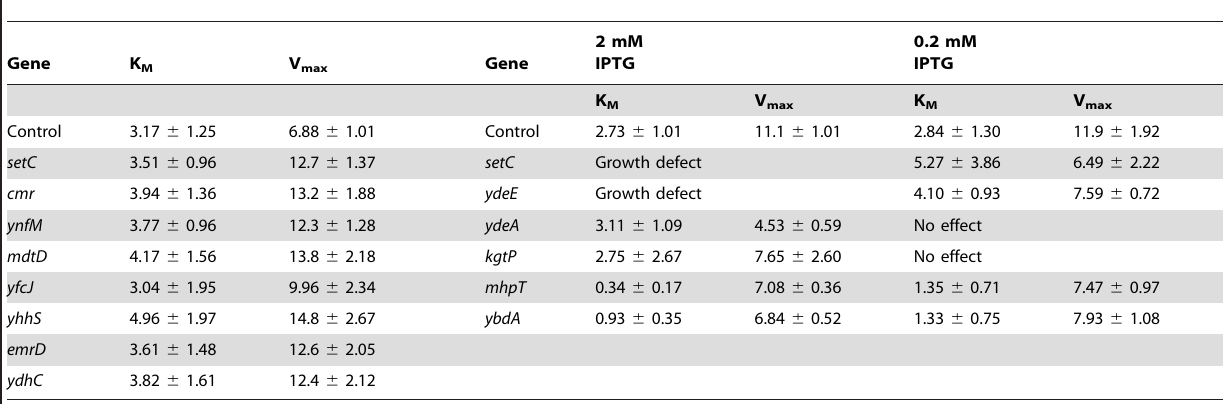
Table 2. K M and V max values * determined from deletion and overexpression studies.